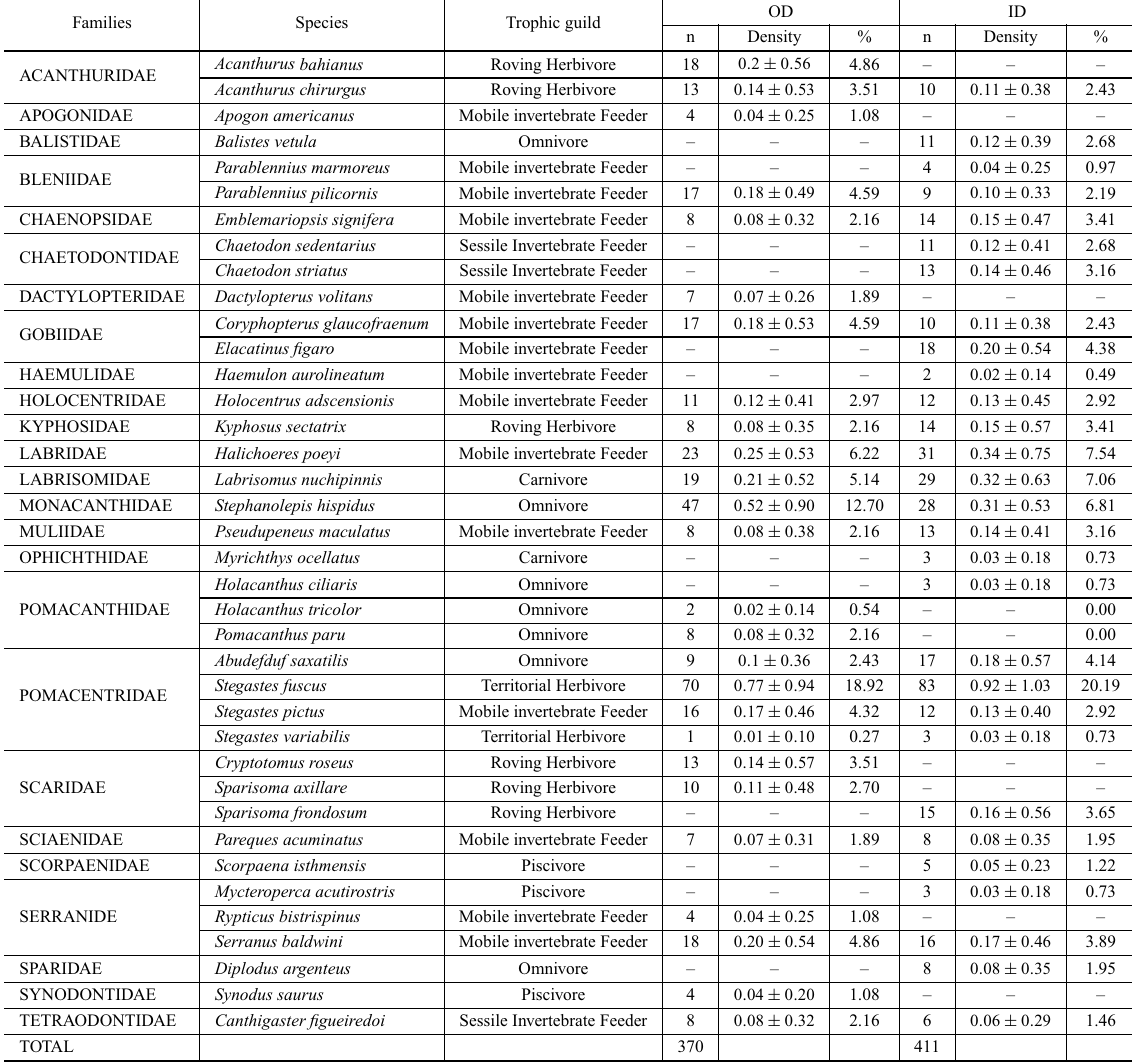
Total composition of reef fish on Maramutá shores detected by visual census and trophic guilds: Total number of specimens counted (n); density per 2.25m 2 (mean ± SE) and percent of total observed on each